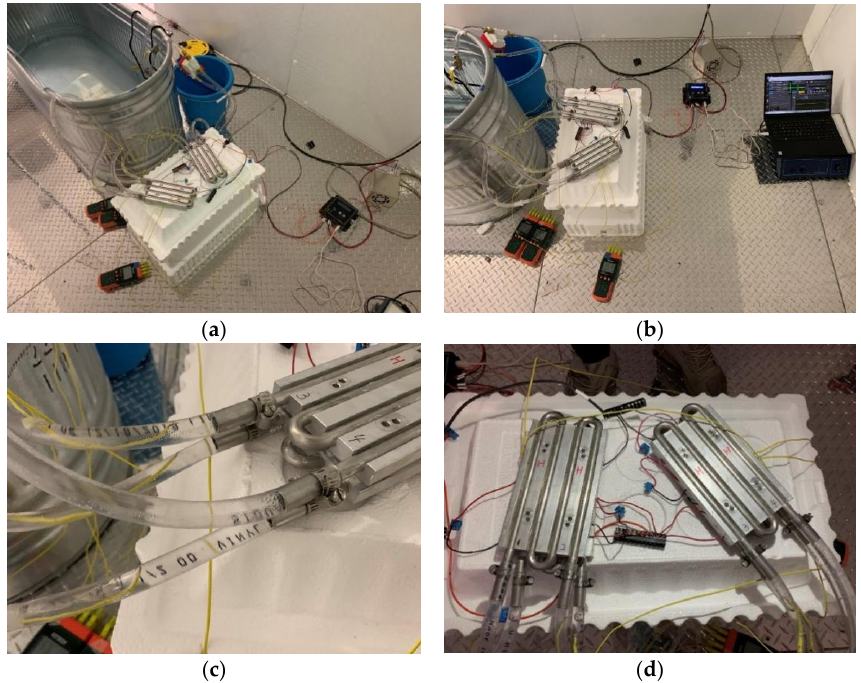
Figure 2. Experiment demonstration: ( a , b ) overview of the system, ( c ) water pipes connected with the heat exchanging panels, and ( d ) heat exchanging panels with the thermoelectric modules in between.